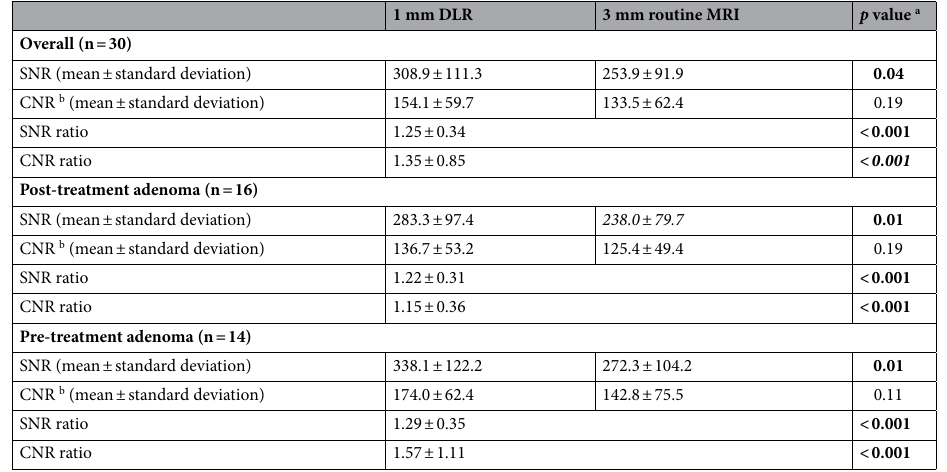
Table 5. Comparison of Image Quality between 1 mm DLR MRI and 3 mm Routine MRI. Bold values used for emphasizing only values below p value < 0.05. 1 mm DLR MRI = 1 mm slice thickness MRI with deep learning-based reconstruction, 3 mm routine MRI = 3 mm slice thickness MRI, SNR = signal-to-noise ratio, CNR = contrast-to-noise ratio. a p value was calculated using paired contrast enhancement. b CNR of tumour was measured in reference to the brain parenchyma (CNR of brain parenchyma) and normal pituitary gland (CNR of normal pituitary